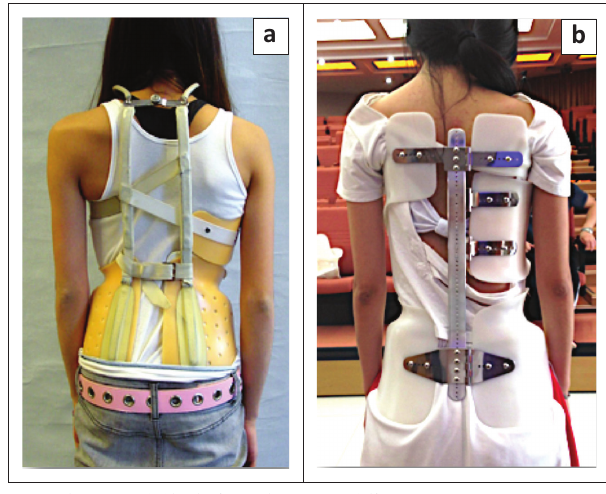
FIGURE 4: (a) Patient with a thoracolumbar curve, (b) treated with a Providence brace.